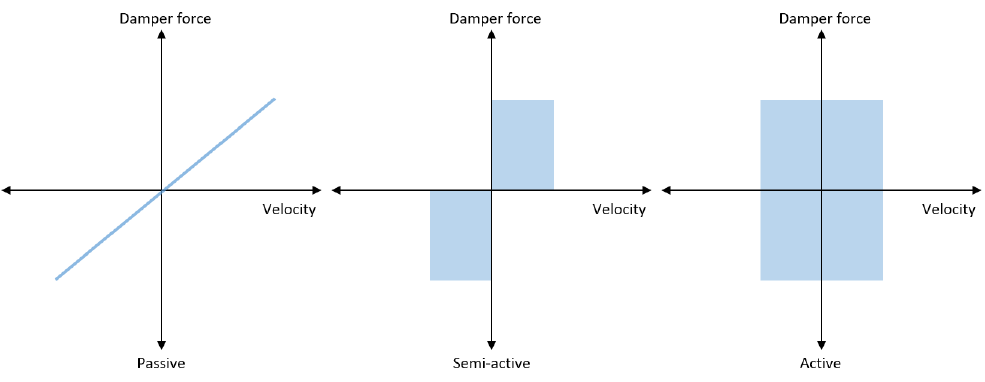
Figure 1. Force-piston velocity diagram of different kinds of ideal